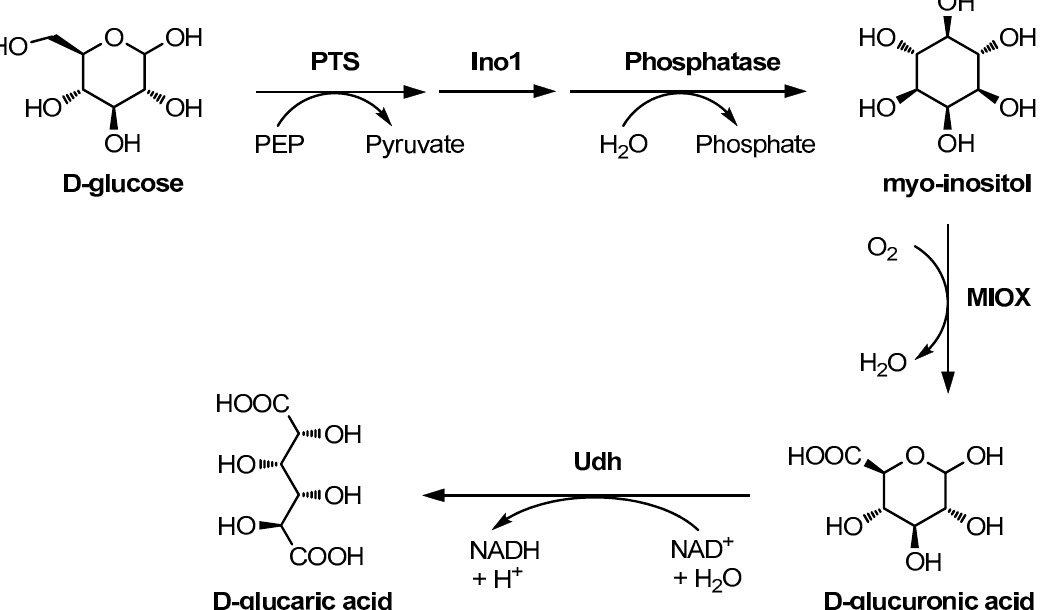
Figure 8. Designed pathway for the production of d -glucaric acid in E. coli. PTS = phosphoenolpyruvate-dependent phosphotransferase system; phosphatase = SuhB, an endogenous E. coli enzyme; PEP = phosphoenolpyruvate; MIOX = myo -inositol oxygenase; Udh = uronate dehydrogenase; [106].